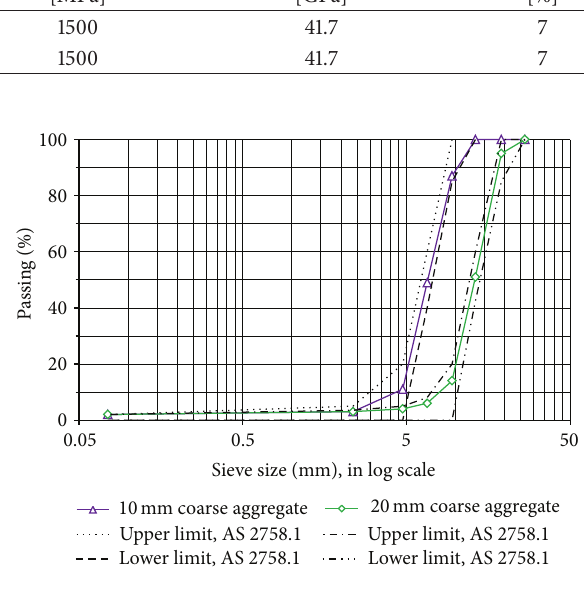
Figure 2: Coarse aggregate grading